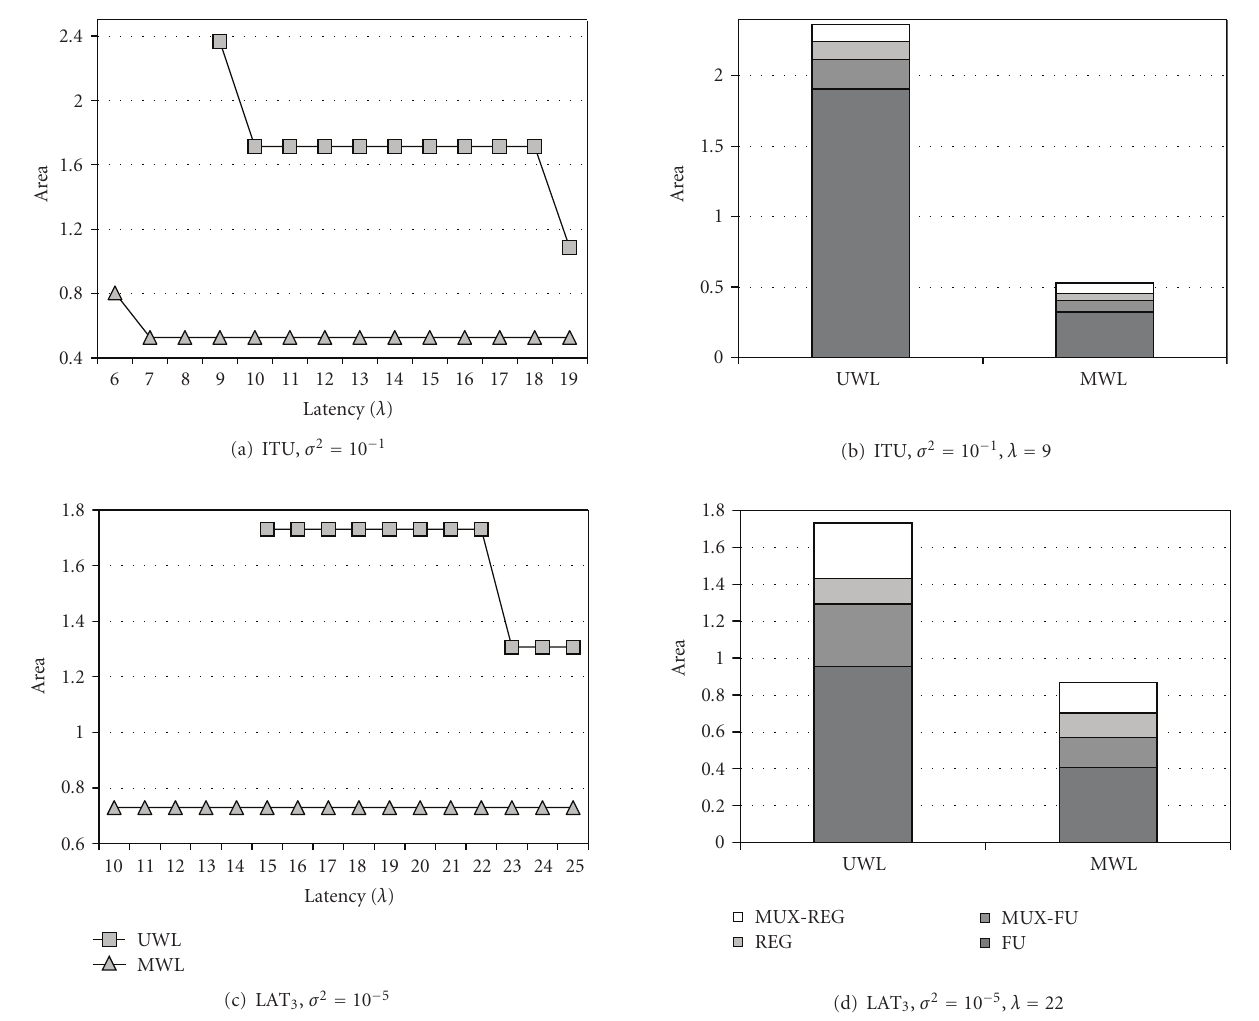
Figure 4: UWL versus MWL: homogeneous implementations